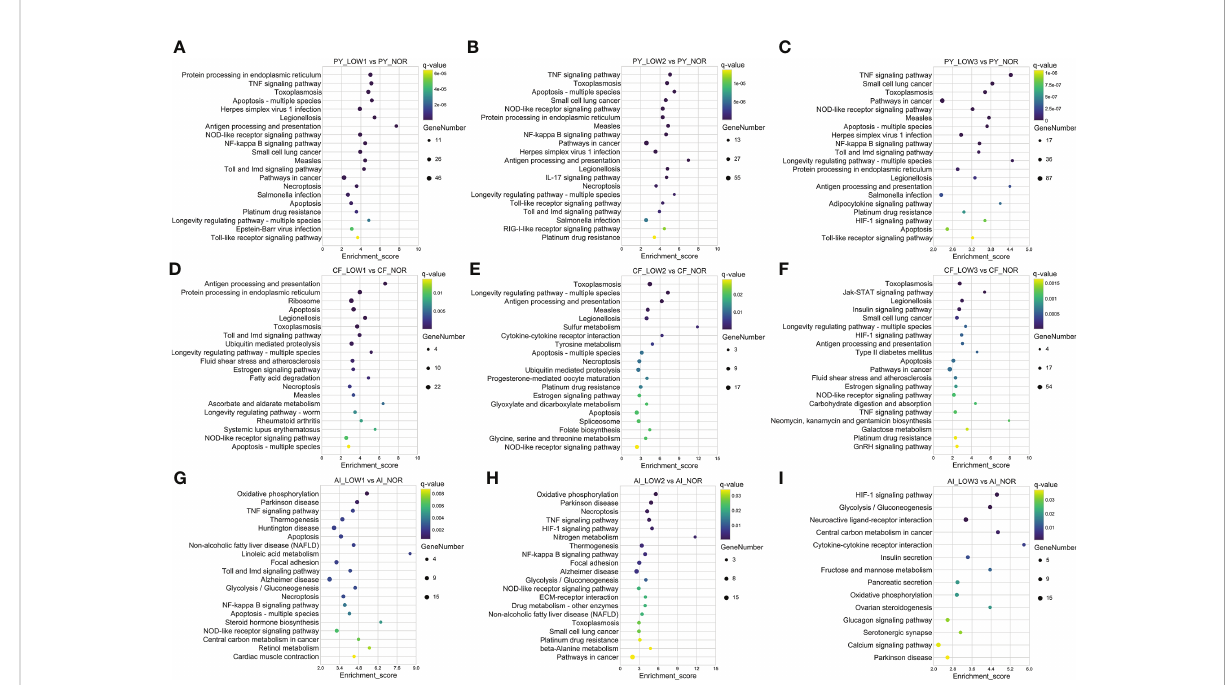
FIGURE 3 Top 20 signi fi cantly enriched KEGG pathways of upregulated DEGs in the Yesso scallop (A – C) , Zhikong scallop (D – F) , and bay scallop (G – I) exposed to different levels of hypoxia stress. (PY, Patinopecten yessoensis ; CF, Chlamys farreri ; AI, Argopecten irradians ; LOW1-LOW3, hypoxia stress associated with DO levels of 6 mg/L, 4 mg/L, and 2 mg/L, respectively; NOR, normal conditions at 15°C and 8 mg/L